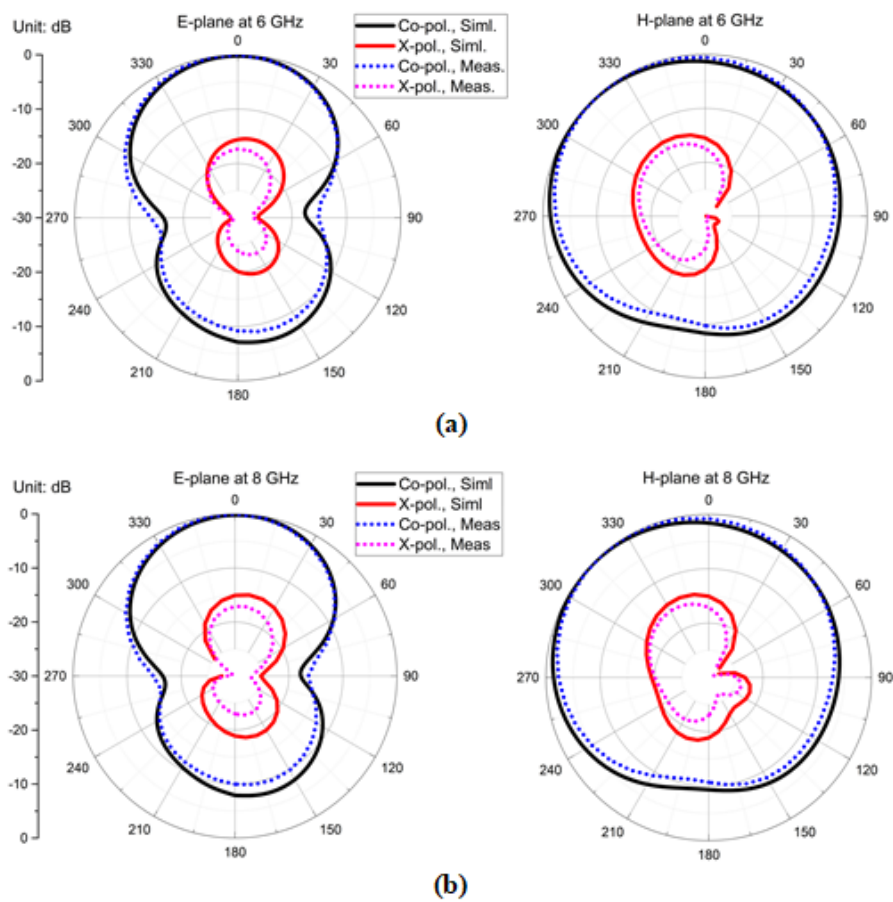
Figure 21. Simulated and measurement patterns for the four-element antenna configuration: ( a ) E-and H-plane at 6 GHz and ( b ) E-and H-plane at 8 GHz,